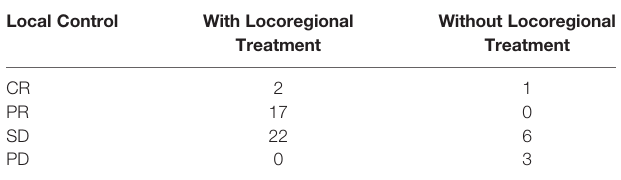
TABLE 2 | The local control of brain metastatic sites in patients with and without locoregional treatment. Local